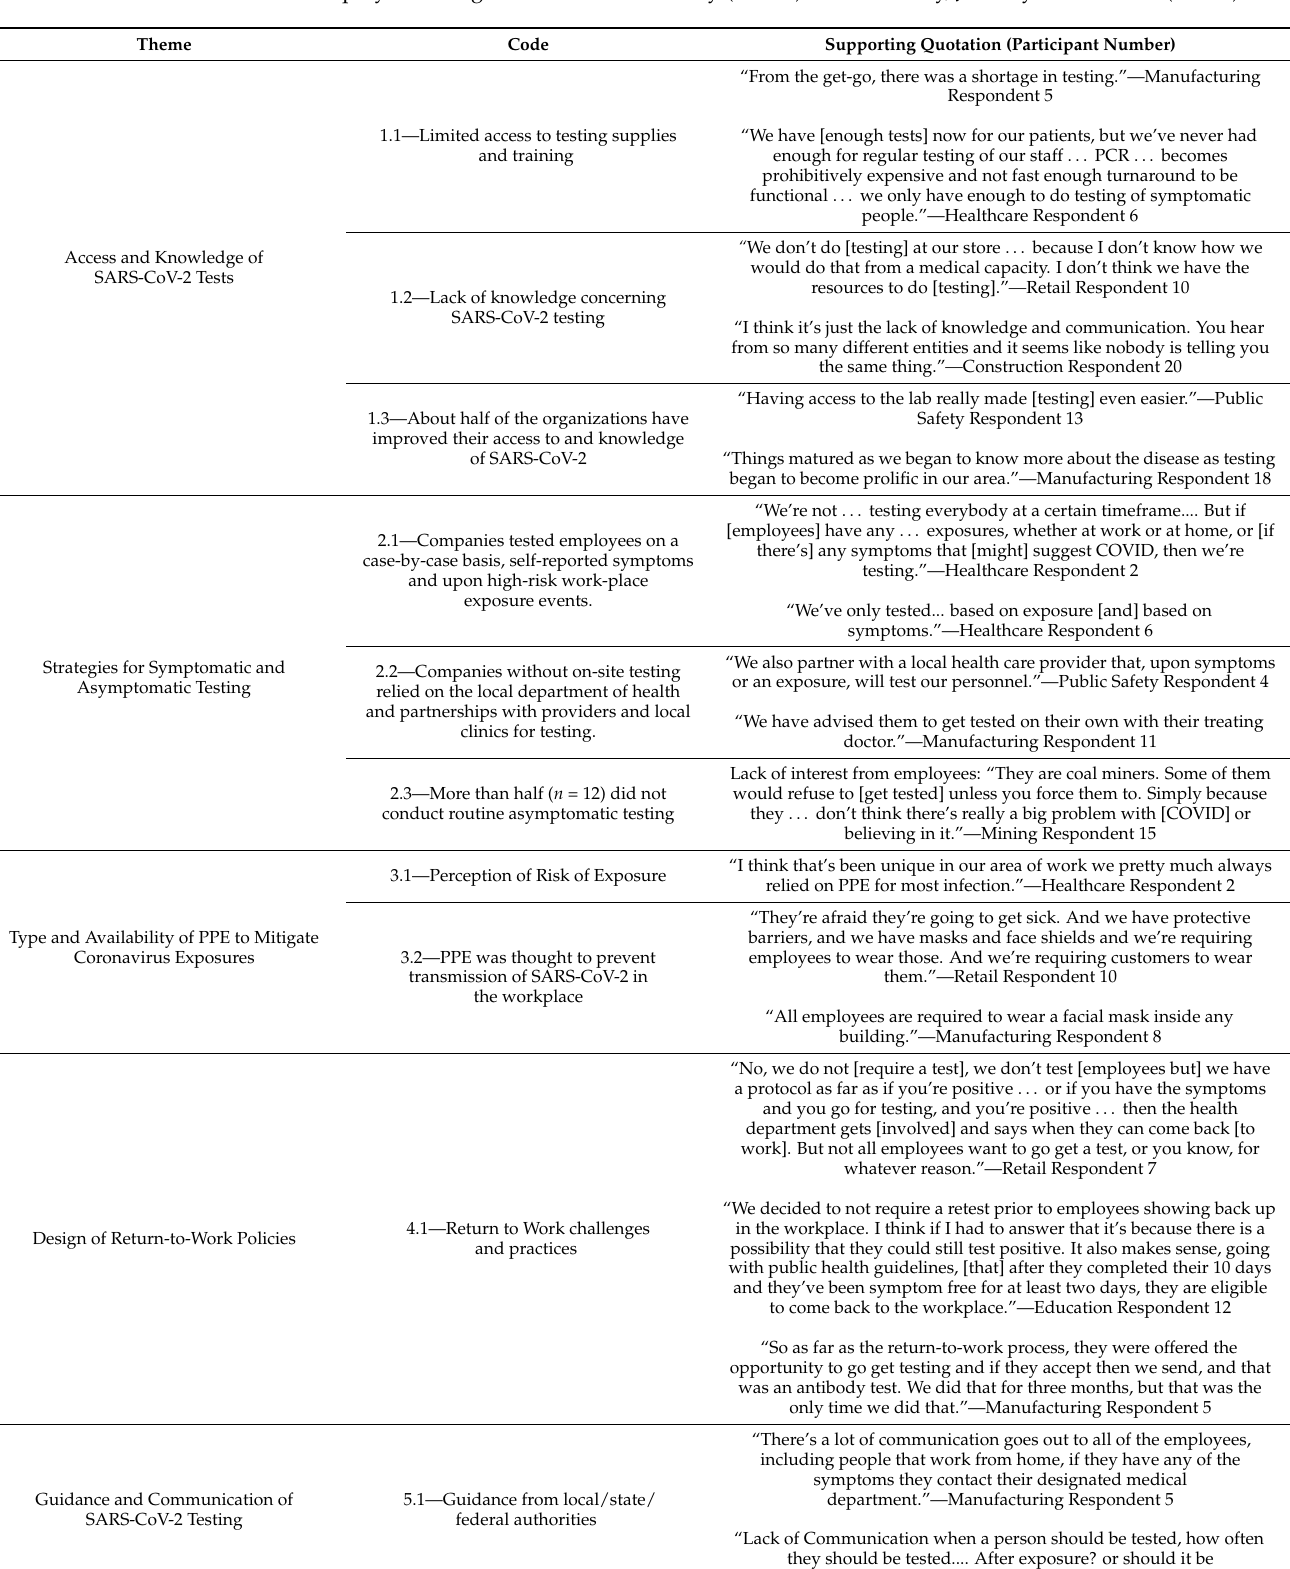
Table 3. Themes and additional supporting quotations from U.S. companies participating in